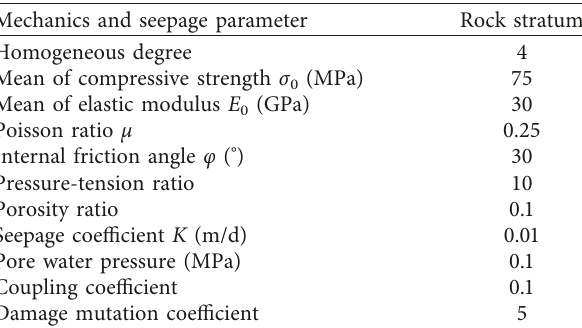
Figure 6: Numerical model. Table 3: Material parameters of the